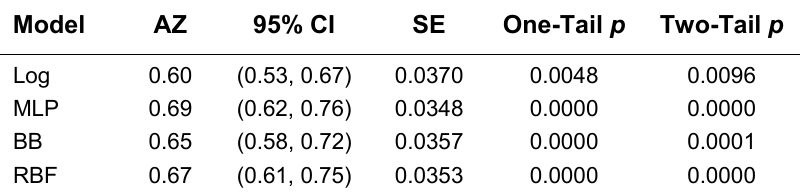
Model Performance Comparison of Area Under the Curve: Administrative and Clinical Data Testing Set — 365-Day Models